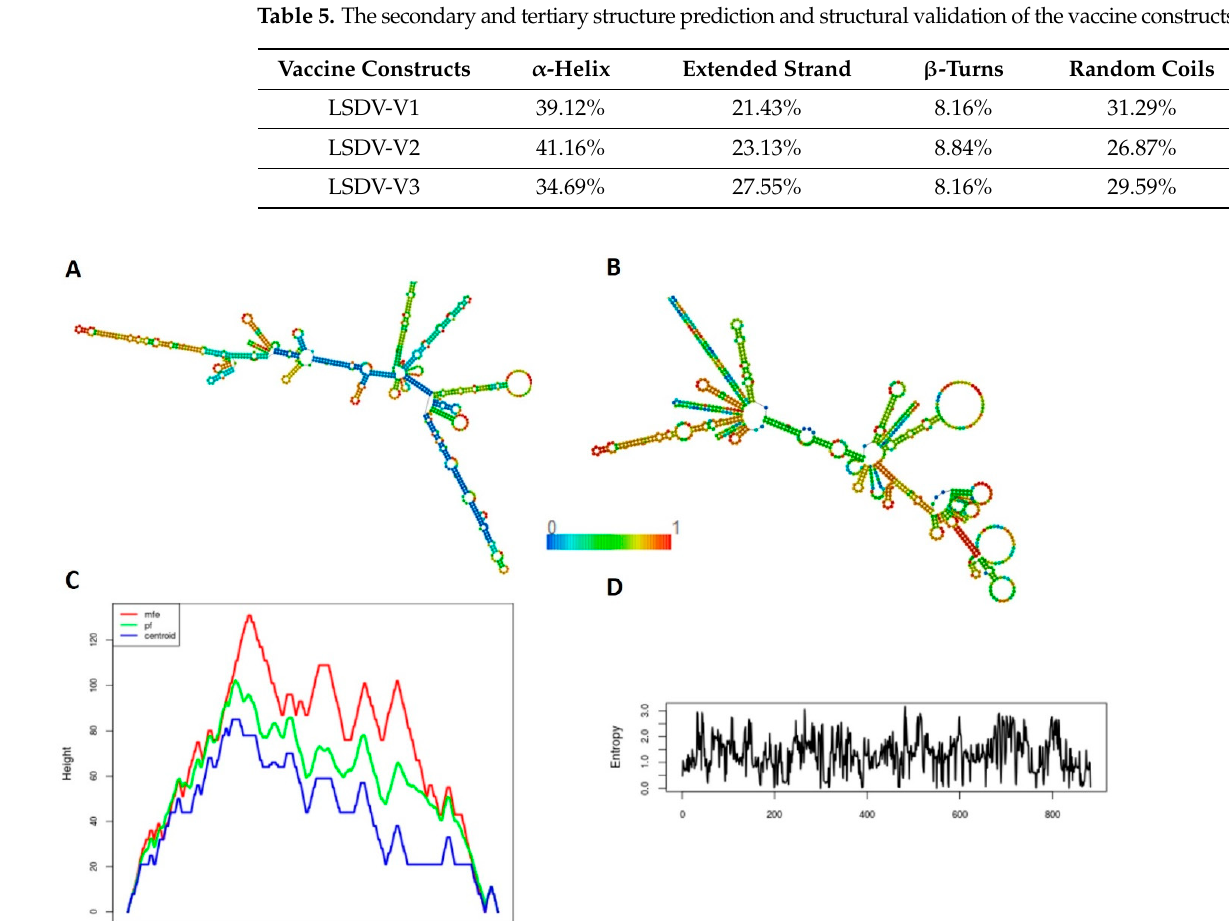
Figure 2. Secondary Structure prediction of the top prioritized LSDV-V2 mRNA construct. ( A ) Model presentation of the minimum free energy of the LSDV-V2 mRNA structure ( B ) The proposed model of the minimum free energy of secondary centroid LSDV-V2 mRNA structure ( C ) The mountain plot representation of the MFE structure, the thermodynamic ensemble of mRNA structure, and the centroid structure. ( D ) The positional entropy plot for each position. Table 5. The secondary and tertiary structure prediction and structural validation of the vaccine constructs.